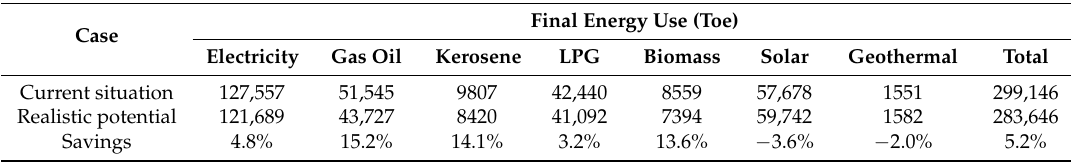
Table 10. Realistic energy saving potential for the Cypriot residential sector.